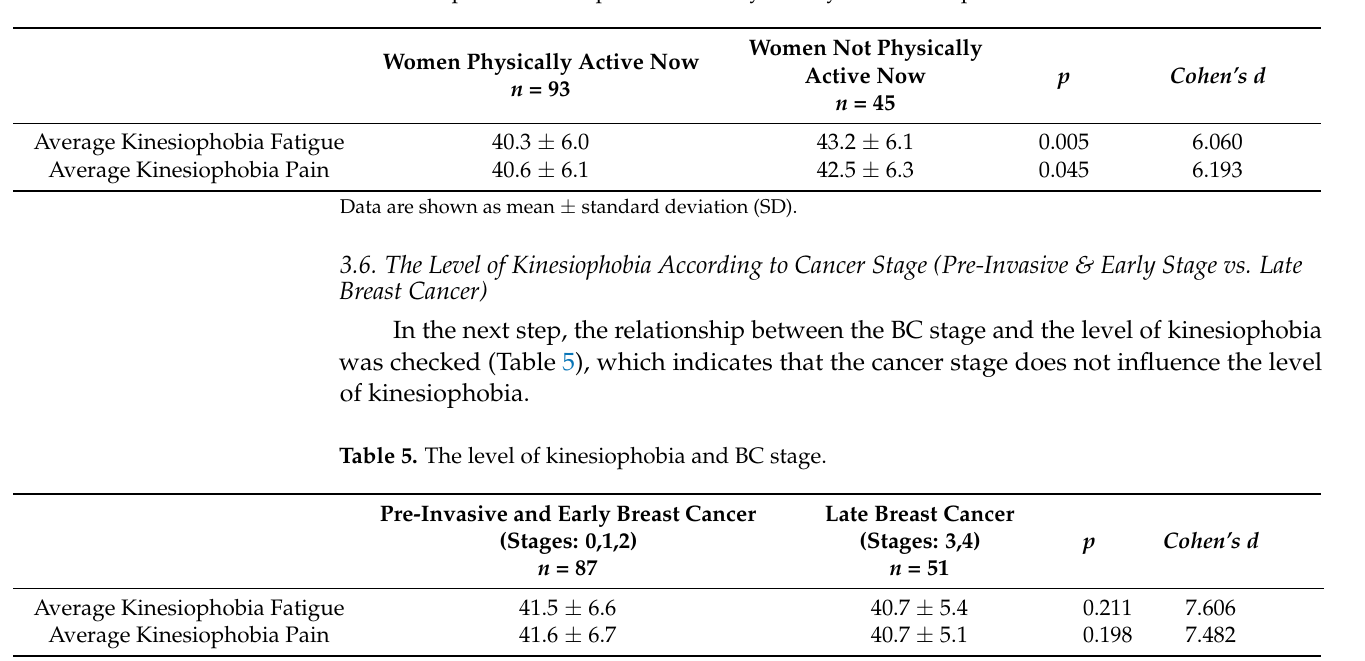
Table 4. Impact of kinesiophobia on lifestyle one year after hospital treatment.